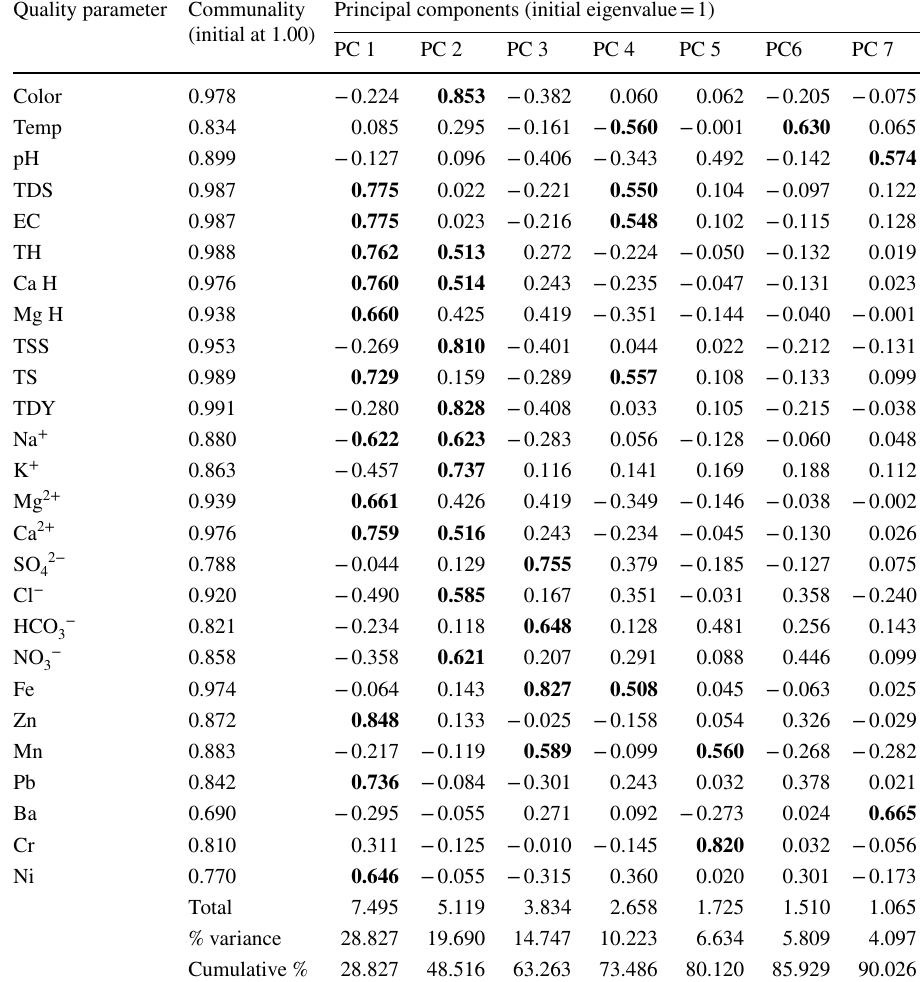
Table 6 Communalities, variabilities and principal components’ loadings of water quality